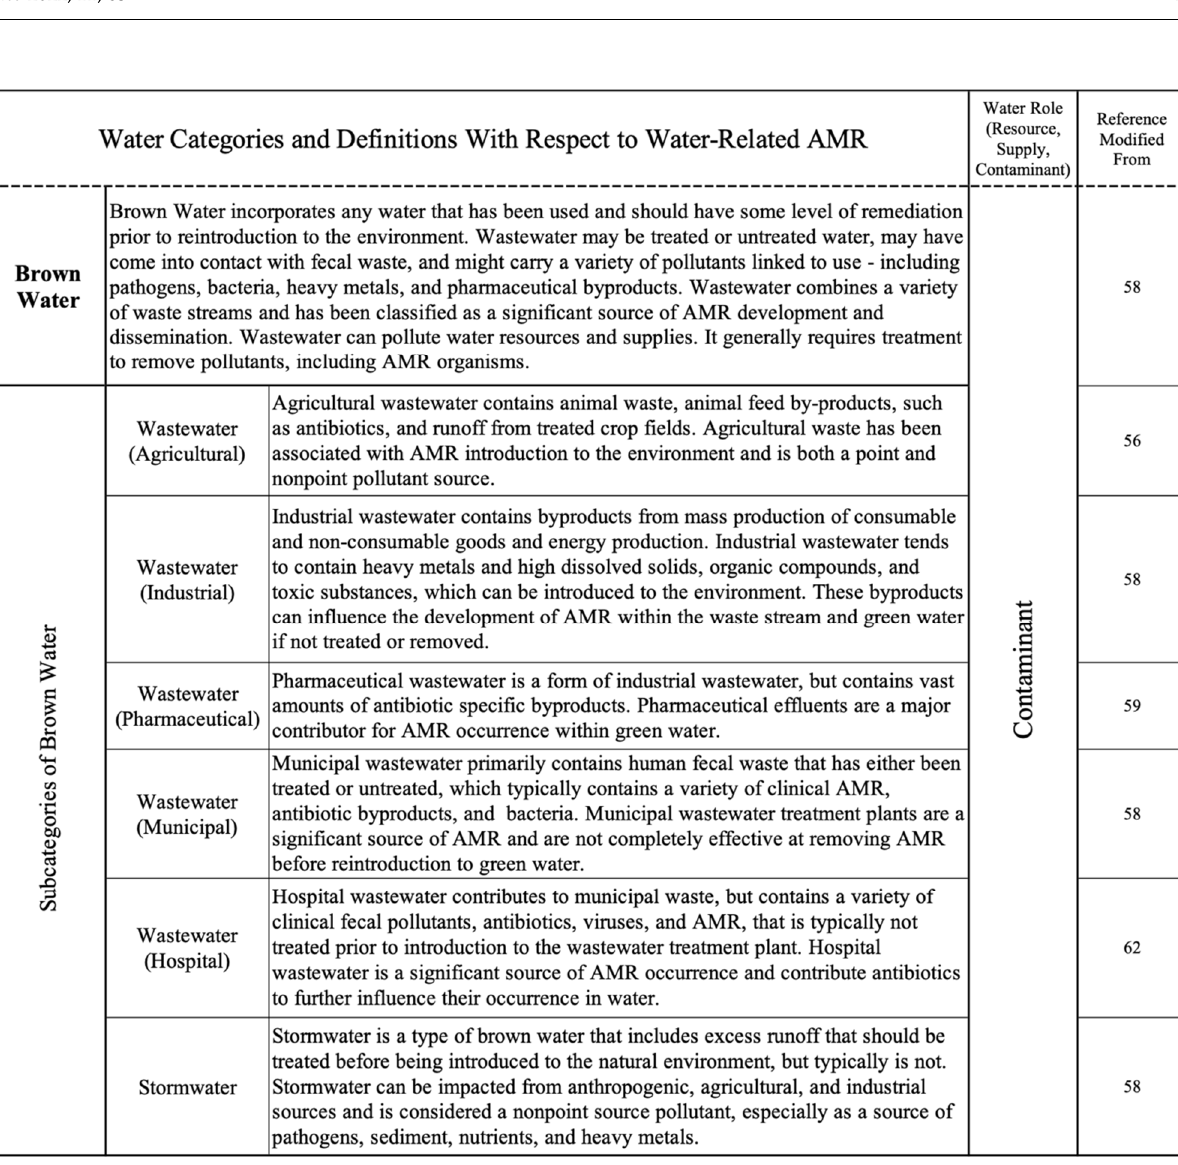
Figure 12 Defined water categories and types associated with water-related AMR. Figure 12. Defined water categories and types associated with water-related